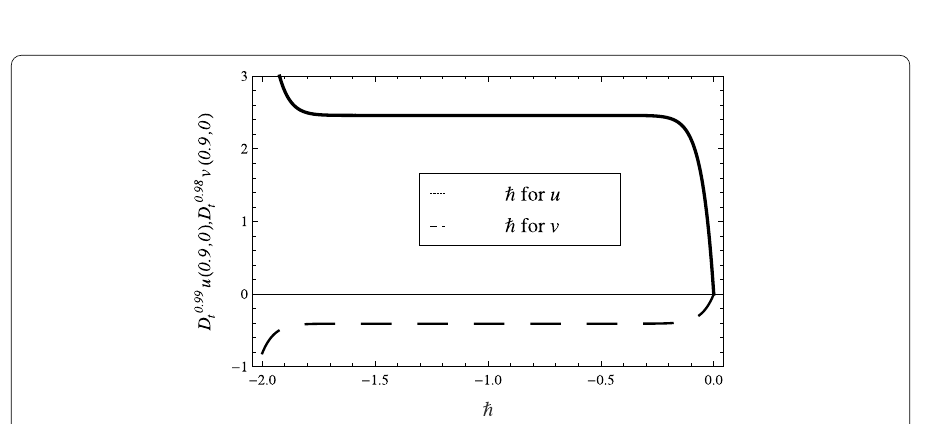
Figure 5 (cid:2) -curve using 20 terms of approximation for Example 3